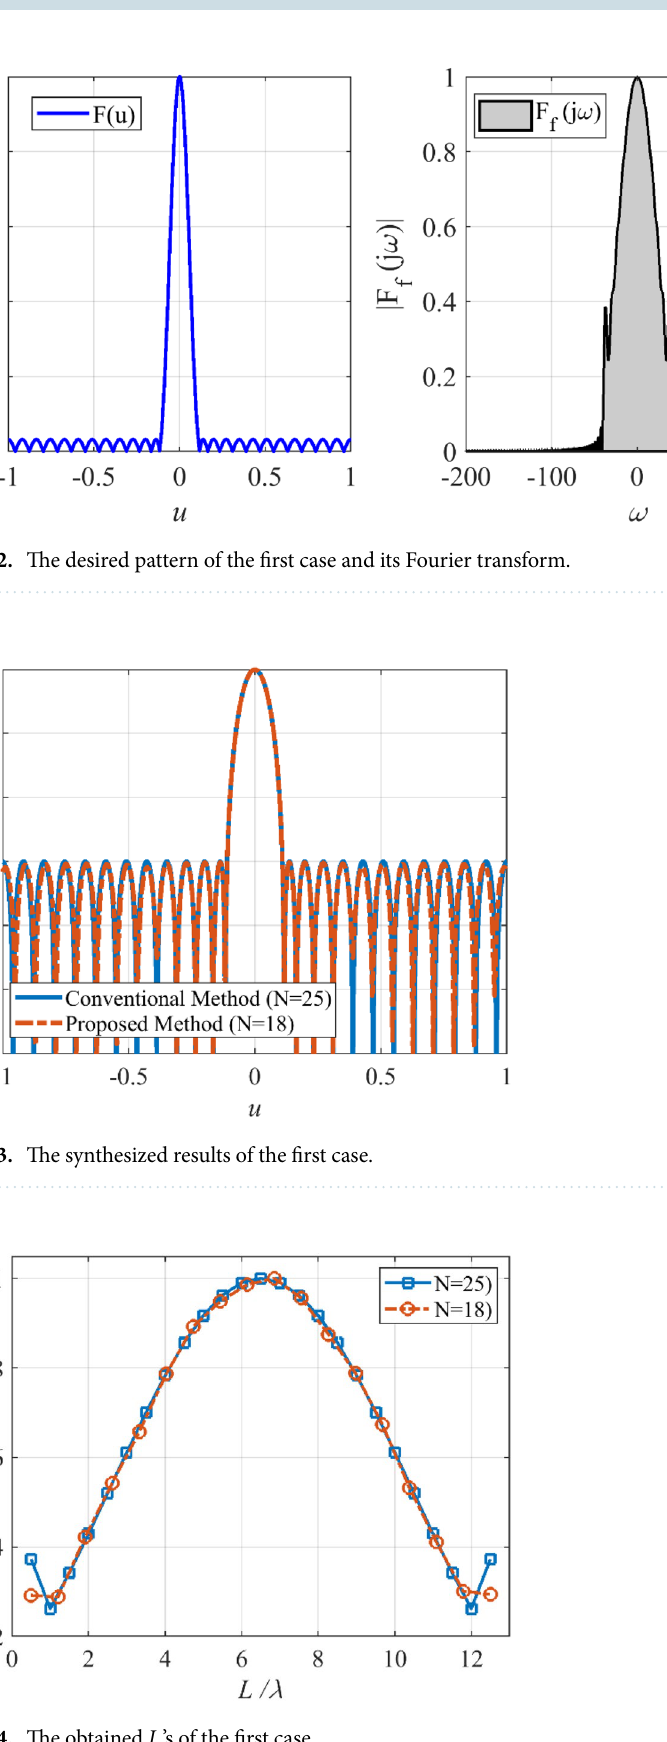
Figure 4. The obtained I n ’s of the first